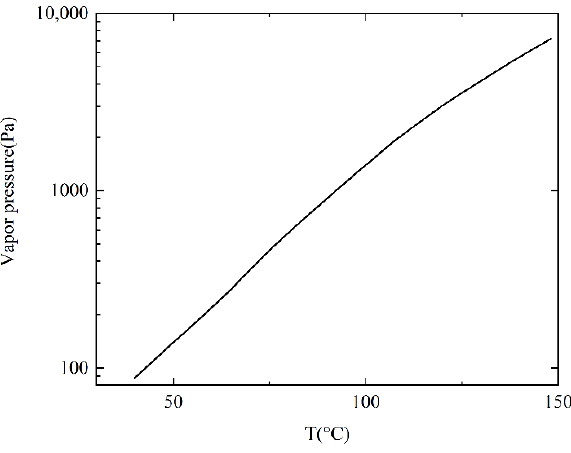
Figure 9. The relationship between oil vapor pressure and